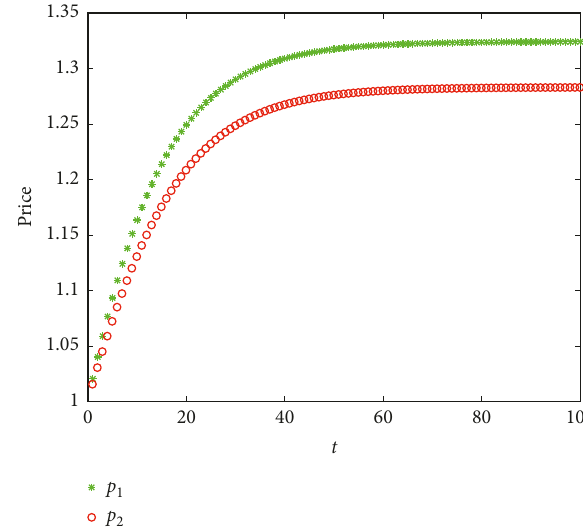
Figure 1: The trajectories of p